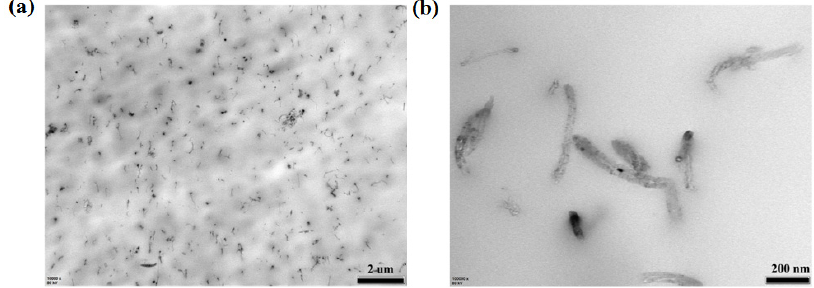
Figure 3. Transmission electron microscopy (TEM) images of RC samples at different